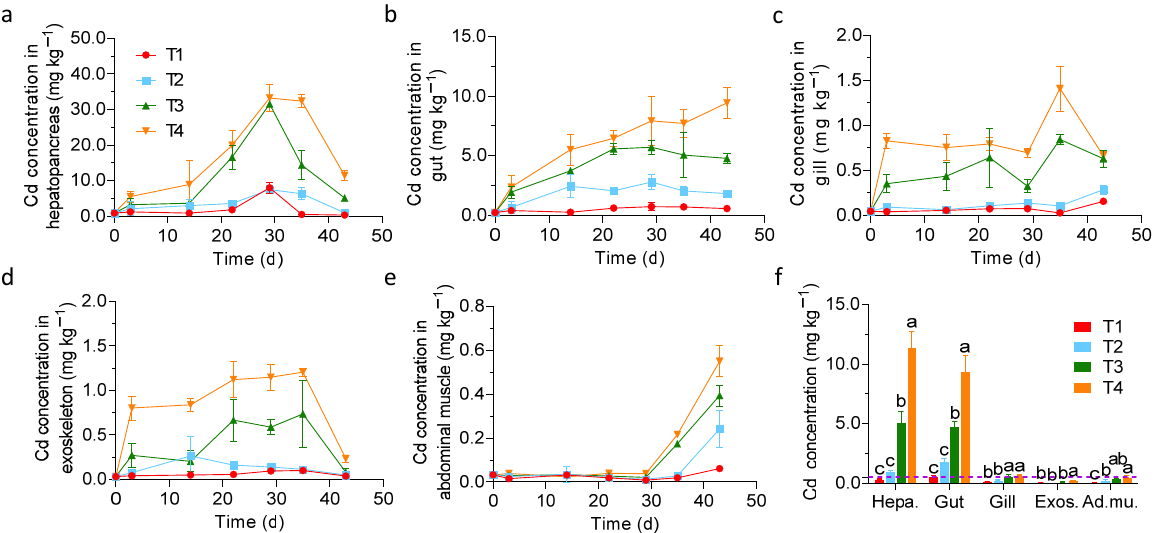
Figure 4. The dynamic changes of Cd concentration in crayfish organs of different treatments: ( a ) hepatopancreas; ( b ) gut; ( c ) gill; ( d ) exoskeleton; ( e ) abdominal muscle; ( f ) the Cd concentration in crayfish organs of different treatments at 43 d. Different lowercase letters represent significant levels of Cd content among different treatments ( p < 0.05). The purple line (0.5 mg kg –1 ) represents limit standard of Cd in crustaceans of China. The X-axis represents the experimental schedule.